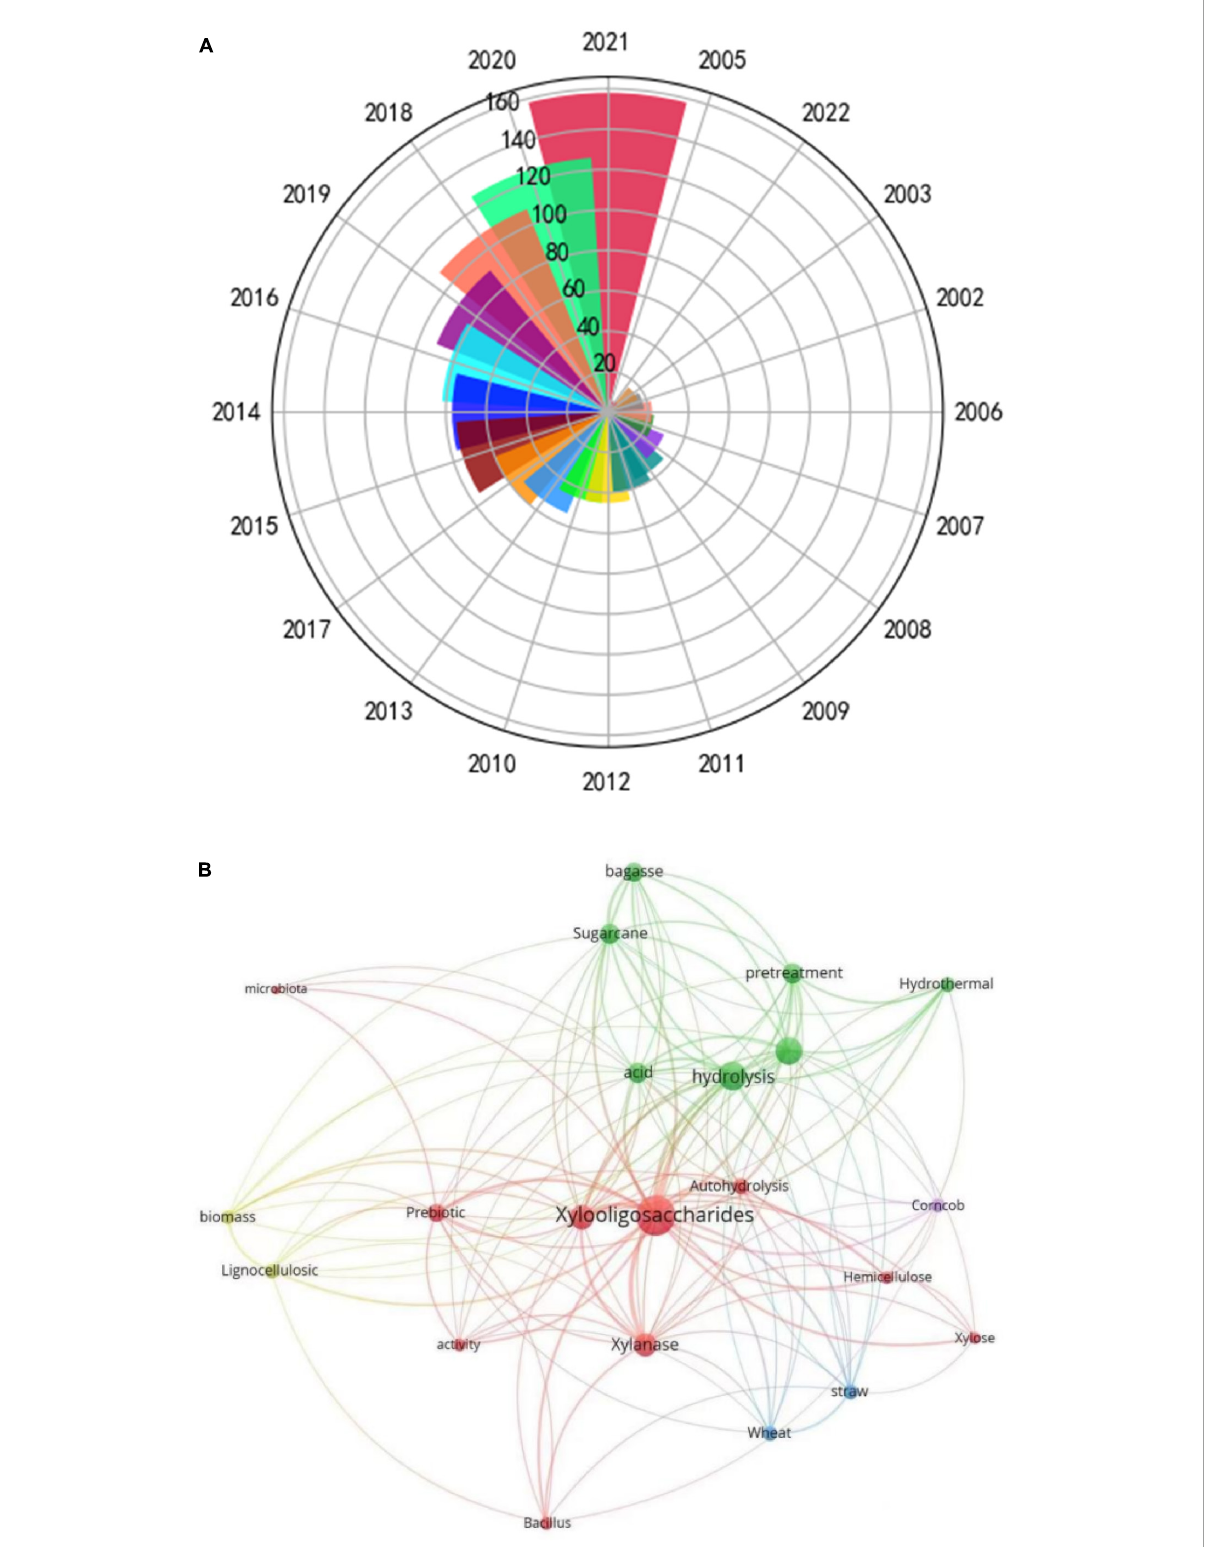
FIGURE2 The number of published studies for xylooligosaccharides in different years (A) ; keywords co-occurrence mapping of XOS, XOS technology, and XOS application (B) .